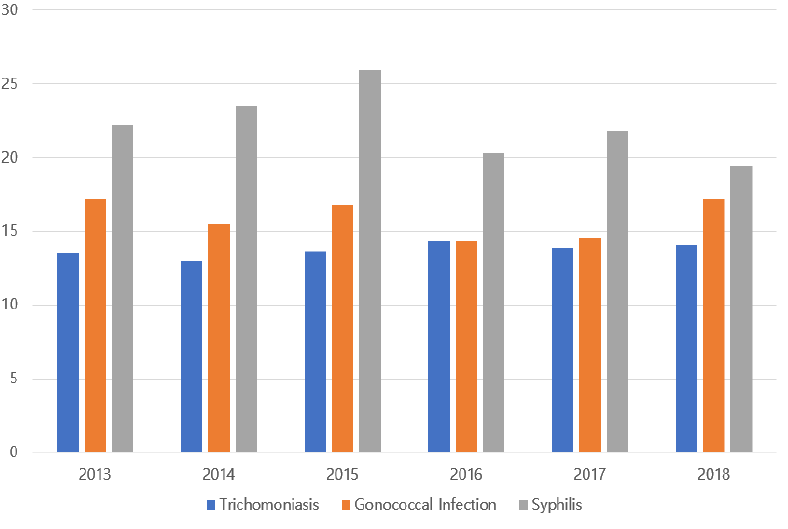
Figure 7. STDs per 10,000 population (2013–2018).